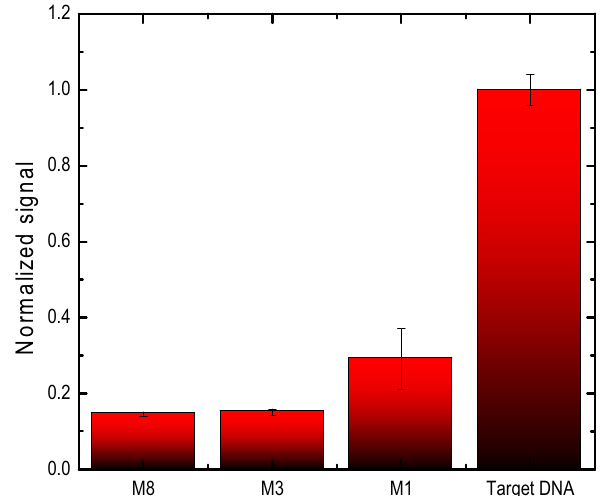
Figure 5: Selectivity examination of the DNAzyme – CHA - based system against di ff erent DNA mismatched species. The error bars represent the standard error of three independent measurements.